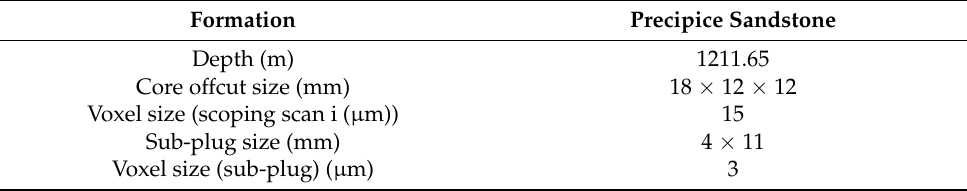
Table 1. Sample scoping scan and sub-plug image